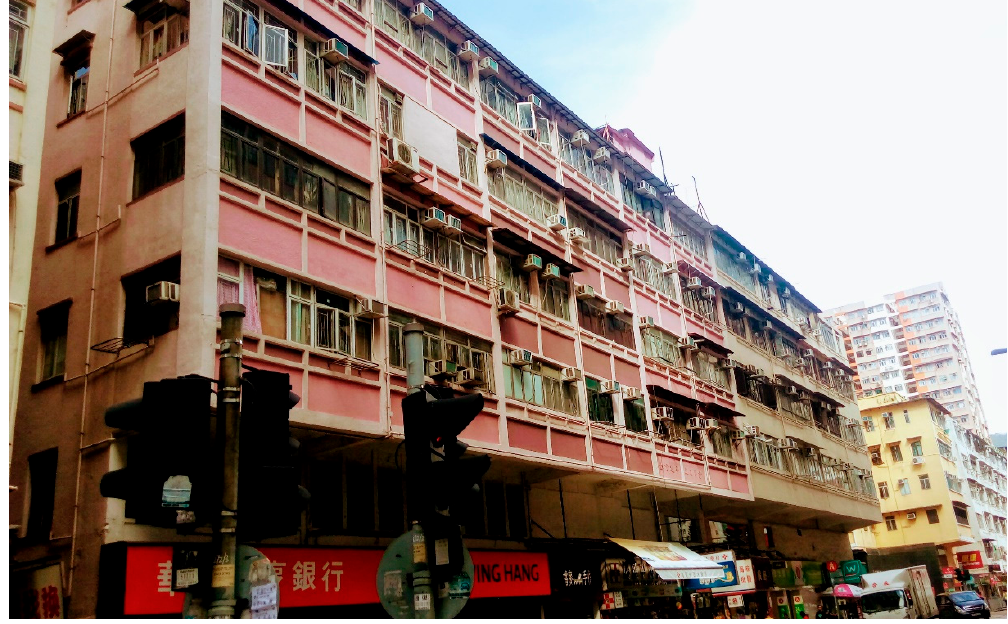
Figure 2. Representation of “Tong Lau”, historical buildings with poor quality and living conditions in Hong Kong. Picture captured in San Po Kong, one of the socially deprived districts in Hong Kong.